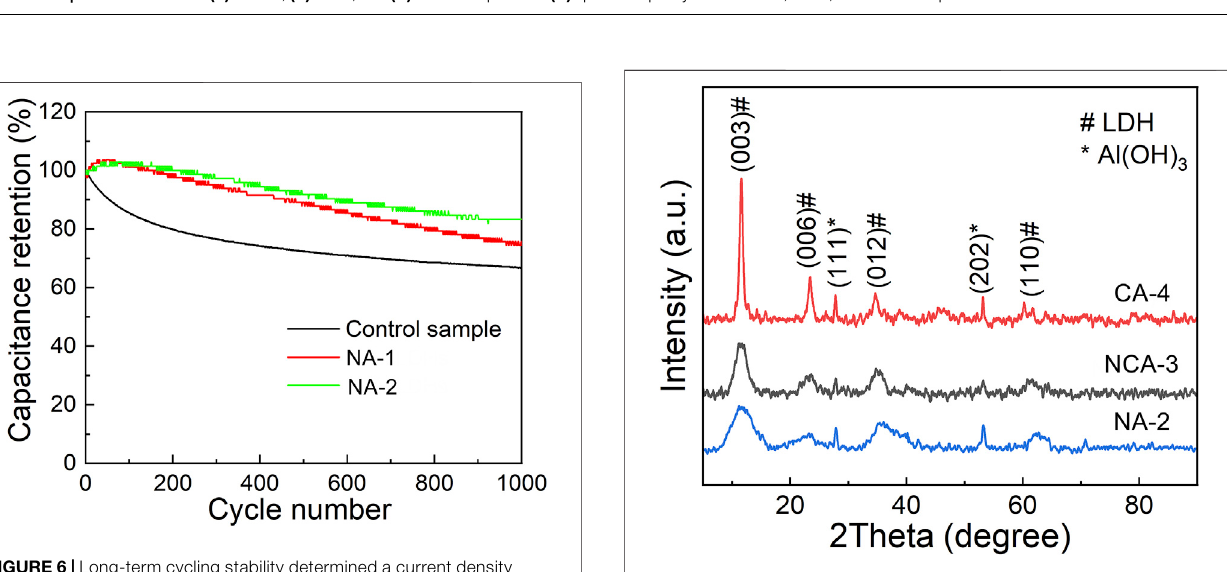
FIGURE 5 | GCDcurvesofthe (A) control, (B) NA-1,and (C) NA-2samplesand (D) speci fi ccapacityofthecontrol,NA-1,andNA-2samplesversusthecurrentdensities.